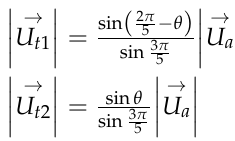
(cid:4652)(cid:4652)(cid:4652)(cid:4652)(cid:4652)⃗ and U (cid:4652)(cid:4652)(cid:4652)(cid:4652)(cid:4652)(cid:4652)⃗ is θ and that the angle between U a t1 (cid:4652)(cid:4652)(cid:4652)(cid:4652)(cid:4652)(cid:4652)⃗ and U (cid:4652)(cid:4652)(cid:4652)(cid:4652)(cid:4652)(cid:4652)⃗ are: t1 t2